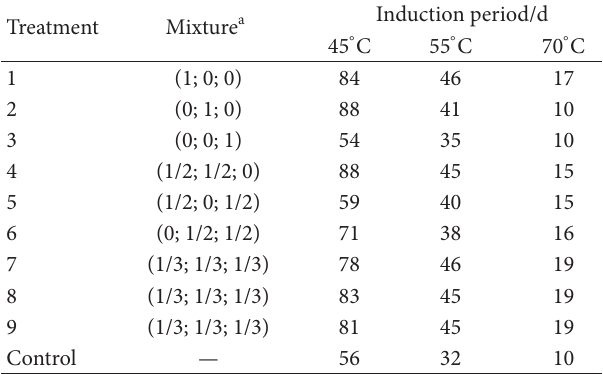
F 3: Relationship between natural logarithm of Induction Period (days) and the assay temperatures of biodiesel stabilized with natural antioxidants, and control sample, obtained by accelerated stove method. T 3: Induction period values (in days) obtained through stove accelerated method, according to simplex-centroid design of